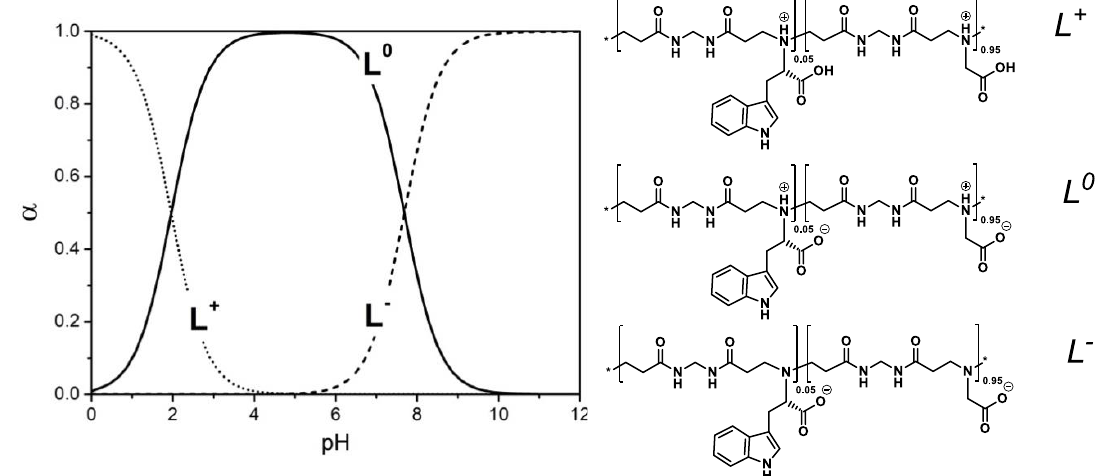
Figure 2. Speciation diagram and ionization states of M-G- L -Trp 5 Figure 2 . Speciation diagram and ionization states of M-G- L -Trp 5 .